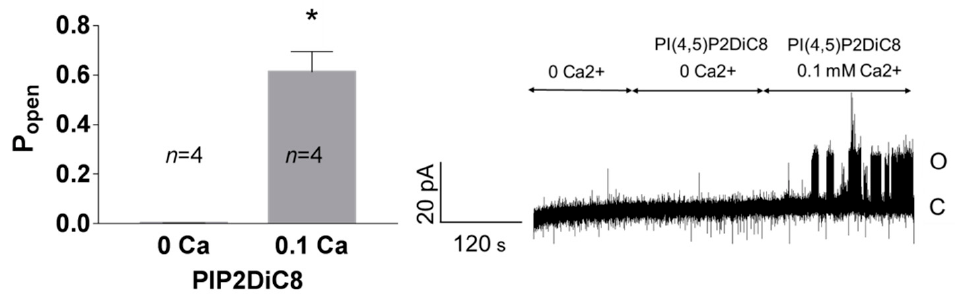
Figure 9. The effect of PI(4,5)P2DiC8 on P open at 50 mV depends on Ca2+. In the inside ‐ out patches, the bath solution containing 10 μ M PI(4,5)P2DiC8 with no free calcium ions was exchanged for the solution containing PI(4,5)P2DiC8 and 0.1 mM Ca2+. Trace represents the exemplary experiment. * p = 0.029, Mann–Whitney test.